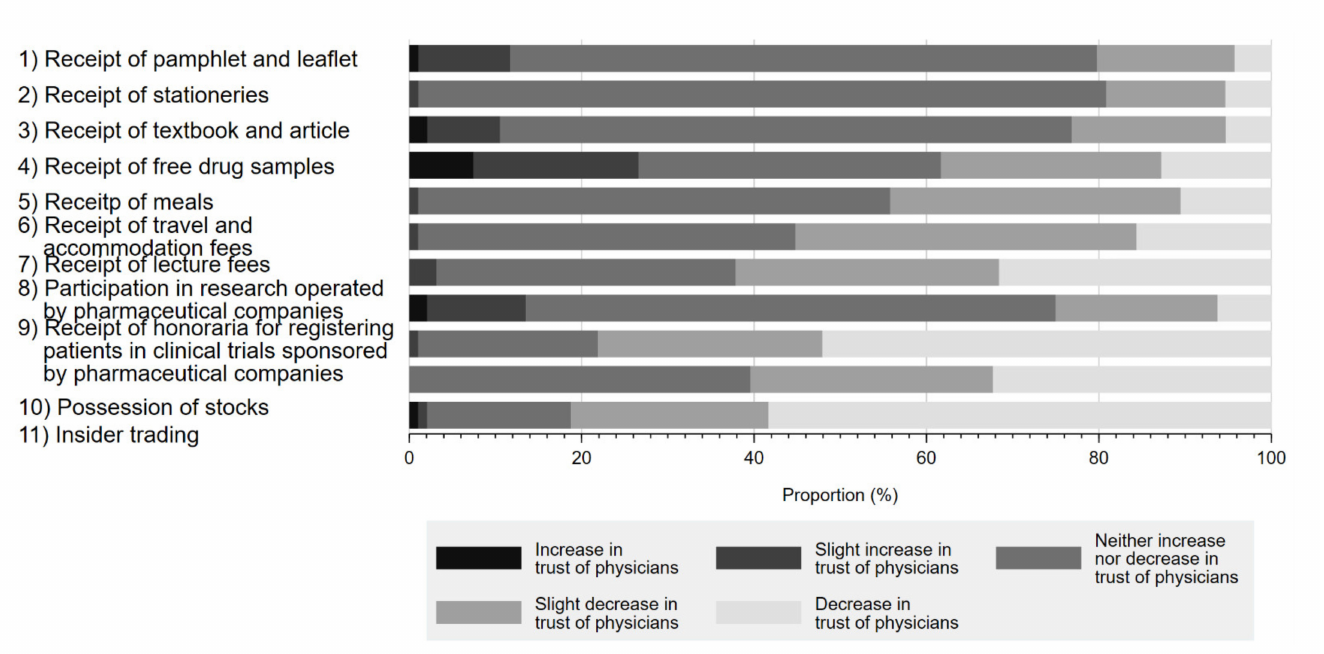
Figure 2. Influence of physician–Pharma interactions on trust in physicians.